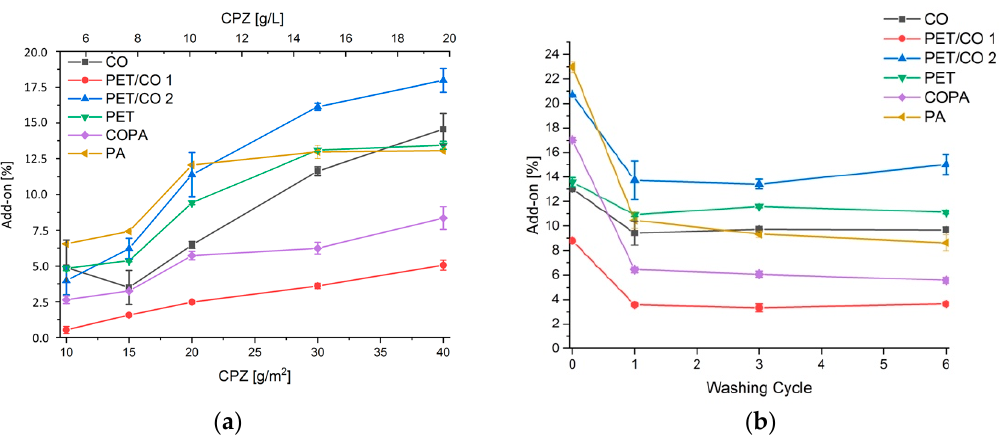
Figure 2. Add-on and washing stability of the finished textiles. ( a ) add-on as CPZ concentration per square meter textile after the first washing test, and ( b ) washing stability after six washing cycles.